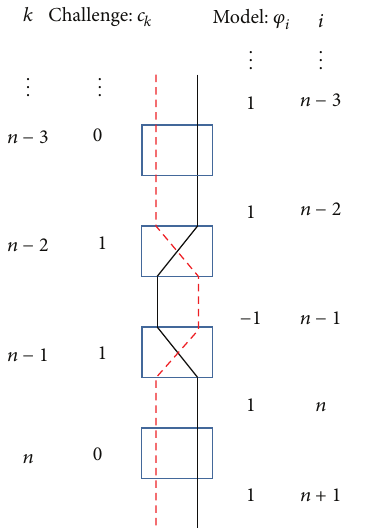
Figure 3: Relationship between the challenge and model.